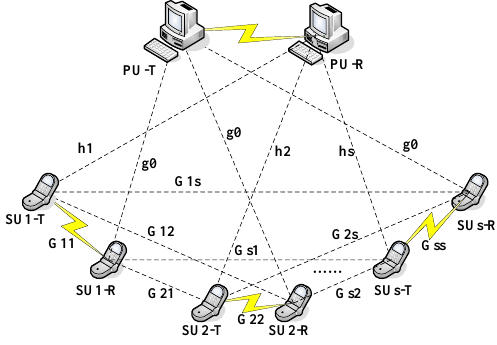
Figure 1. CR system model.